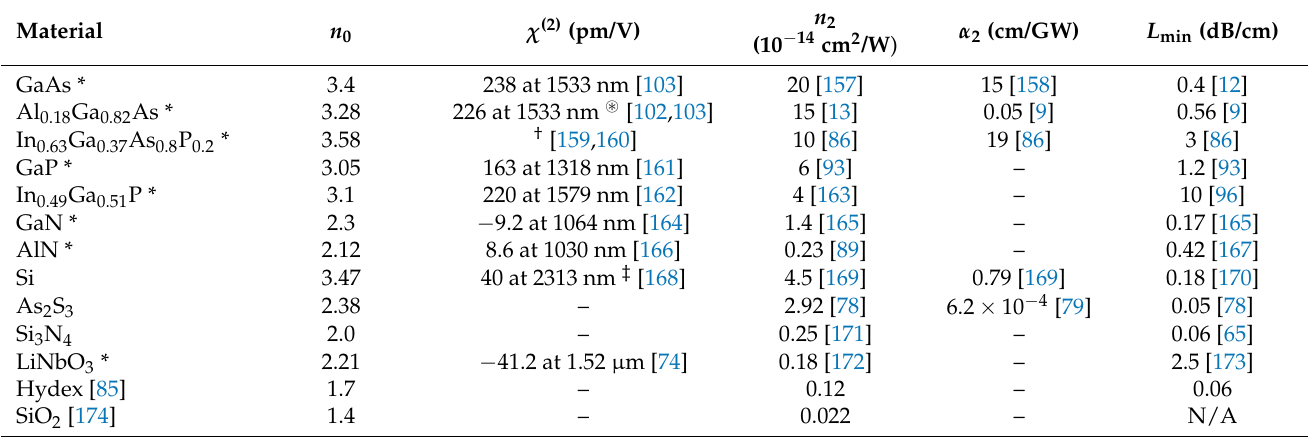
Table 1. Nonlinear waveguide materials and their optical coefficients at 1550 nm unless stated